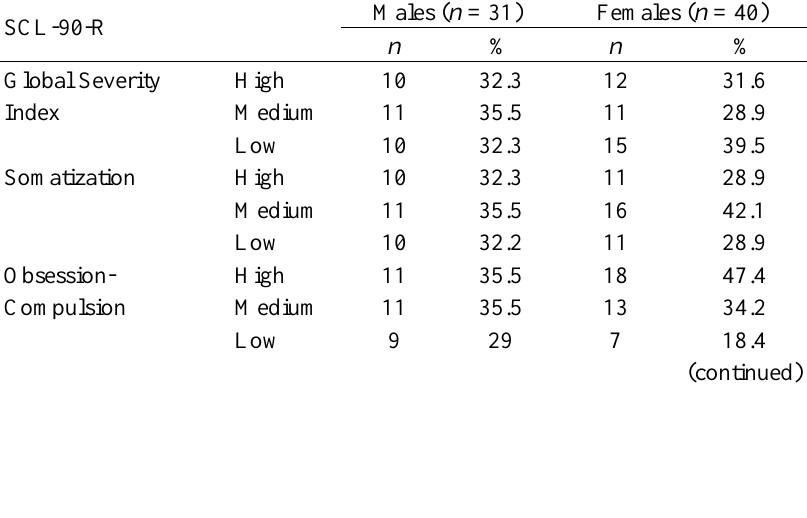
Levels of psychiatric symptomatology in male and female teachers Males ( n = 31) Females ( n = 40) SCL-90-R n % n